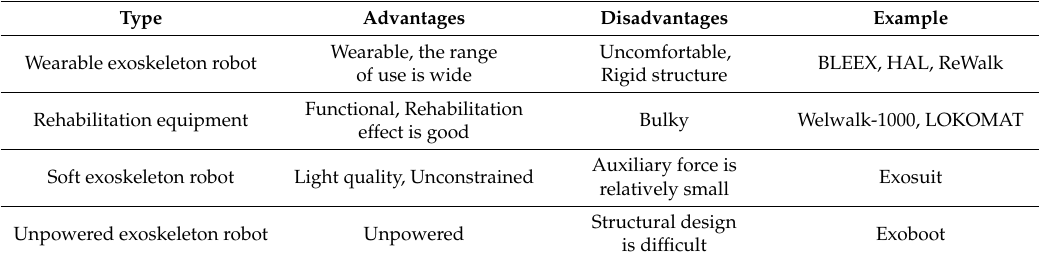
Figure 7. Advanced exoskeleton robot. ( a ) Soft exoskeleton robot; ( b ) Unpowered exoskeleton robot Exoboot. (( a ) was reproduced with permission from [78]; ( b ) was reproduced with permission from [77], Copyright Nature, 2015.) Table 2. Comparison of various types of rehabilitation robots.